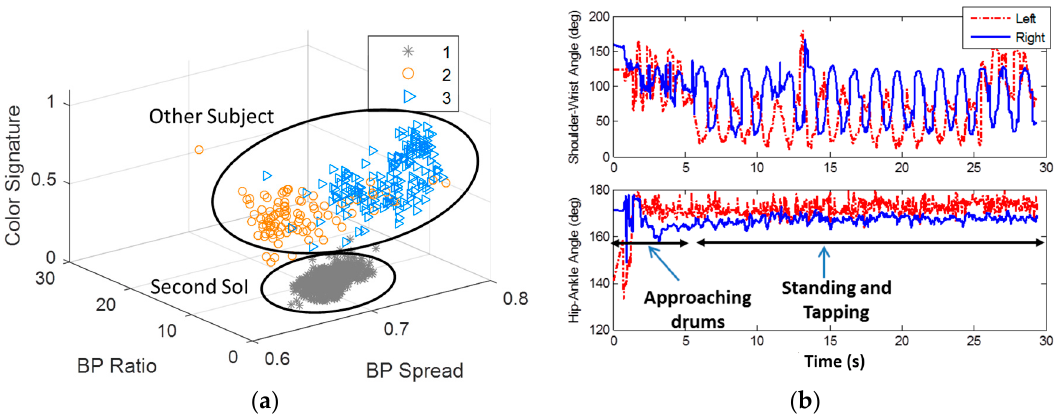
Figure 10. Tapping experiment results. ( a ) shows the SoI of the first KI in the tapping experiment. optimal range is high; ( b ) shows upper and lower limbs orientation over time in tapping